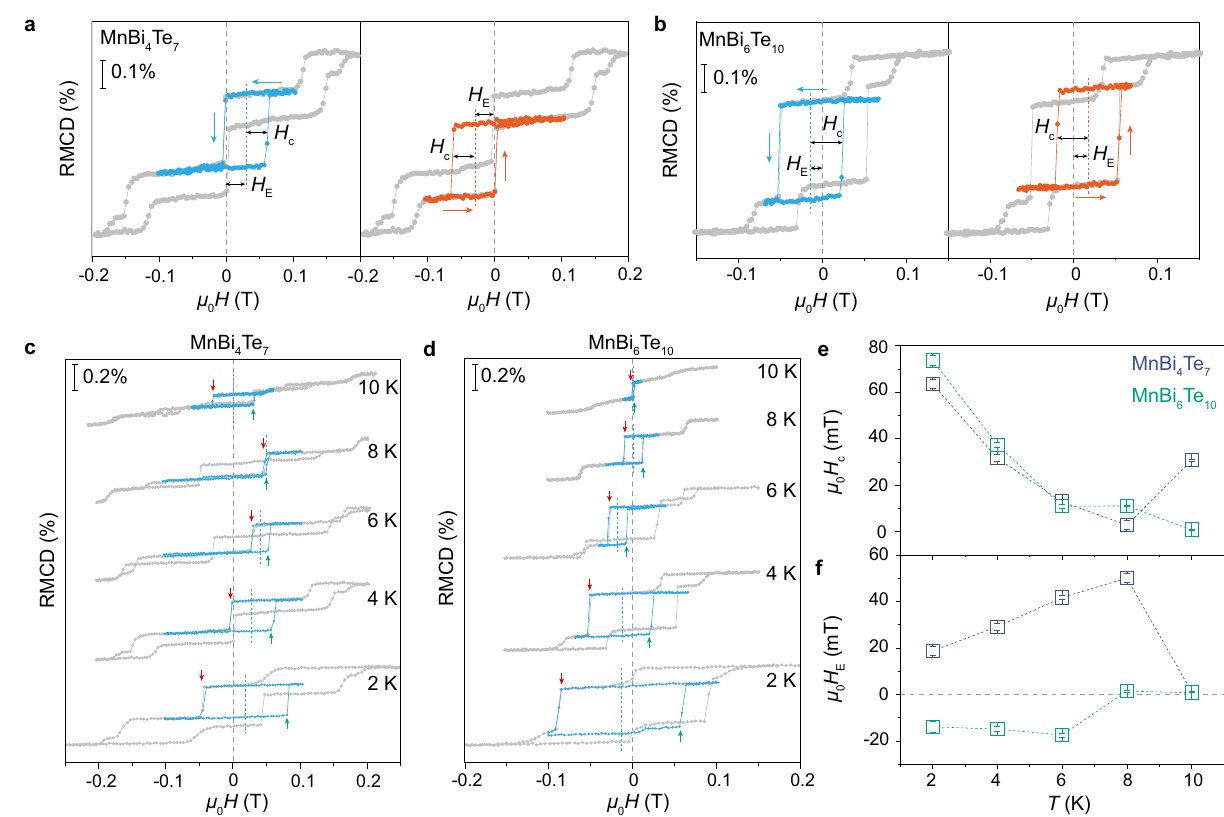
Fig. 4 |ExchangebiaseffectsoftheFMcomponent in MnBi 4 Te 7 and MnBi 6 Te 10 samples. a , b Exchangebiaseffects of the FM component inthe6-SLMnBi 4 Te 7 ( a ) and 6-SLMnBi 6 Te 10 ( b )measured at4K.The directionofthe exchange biascan be tuned by the historical polarization fi eld (blue for positive polarization fi eld and orange for negative polarization fi eld). The exchange bias effect observed in MnBi 6 Te 10 is opposite to that of MnBi 4 Te 7 . Colored dashed lines represent H E .